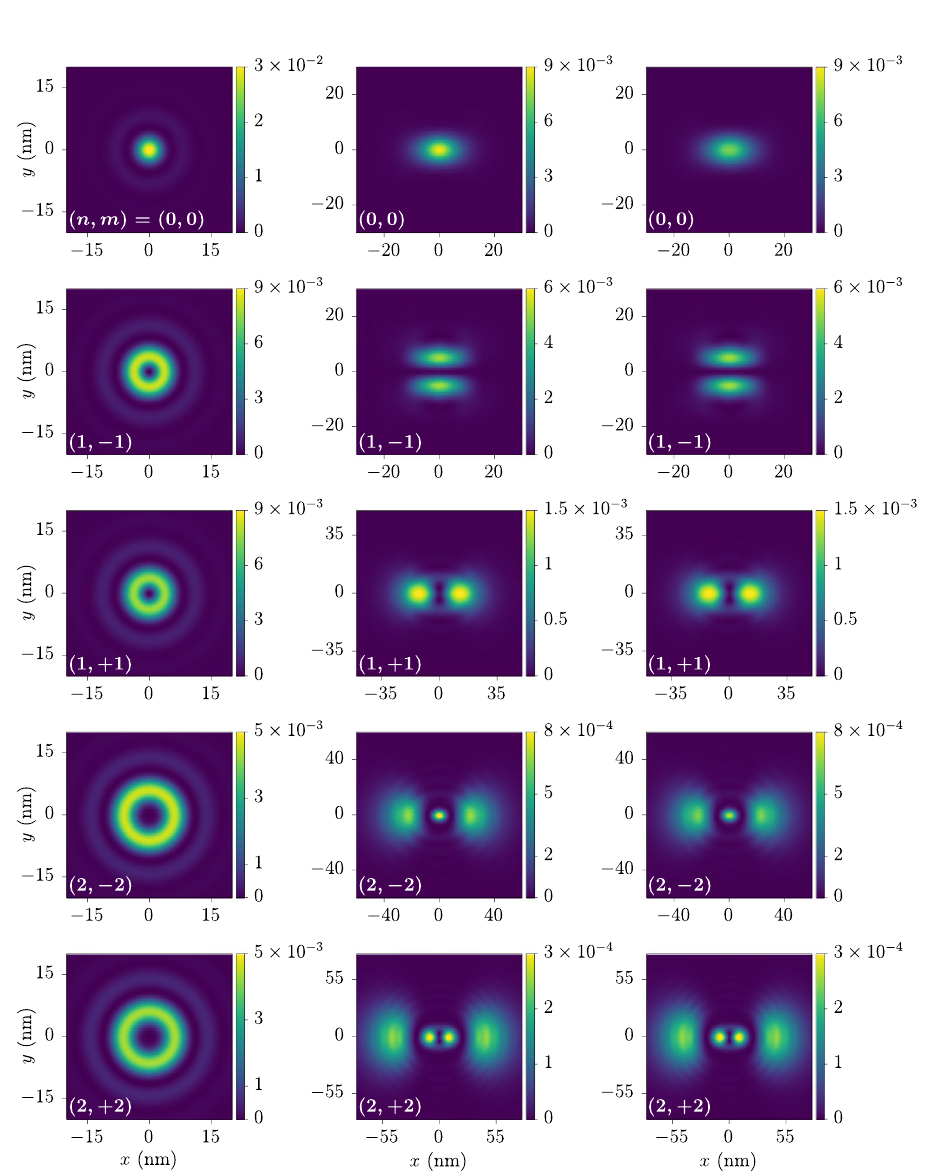
n , m 2 Q . The rows correspond, | ; � ± ; 2 Q n , m (right column). The values of n and | ; � + ; 1 0.7 nm − =